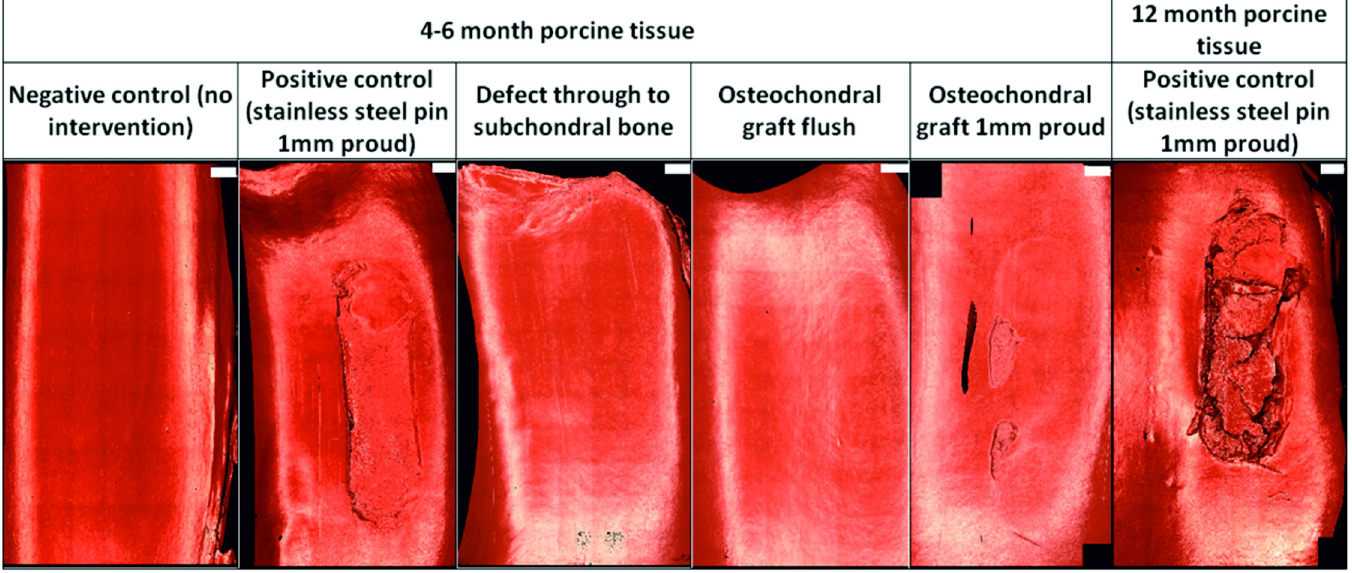
Fig 4. Representative images of Accutrans replicas of the wear scar on femoral trochlea following 3 hours (10,800 cycles) simulation. Images taken using an Alicona IF G5 optical profiler with 5X magnification. Scale bars shown in white at the top right of each image represent 2mm.